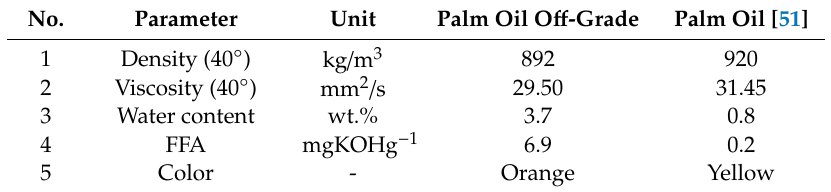
Table 1. Physical properties and free fatty acid (FFA) of crude o ff -grade palm oil compared to palm oil. No. Parameter Unit Palm Oil O ff -Grade Palm Oil [51] 1 Density (40 ◦ ) kg / m 3 892 920 2 Viscosity (40 ◦ ) mm 2 / s 29.50 31.45 3 Water content wt.% 3.7 0.8 4 FFA mgKOHg − 1 6.9 0.2 5 Color - Orange